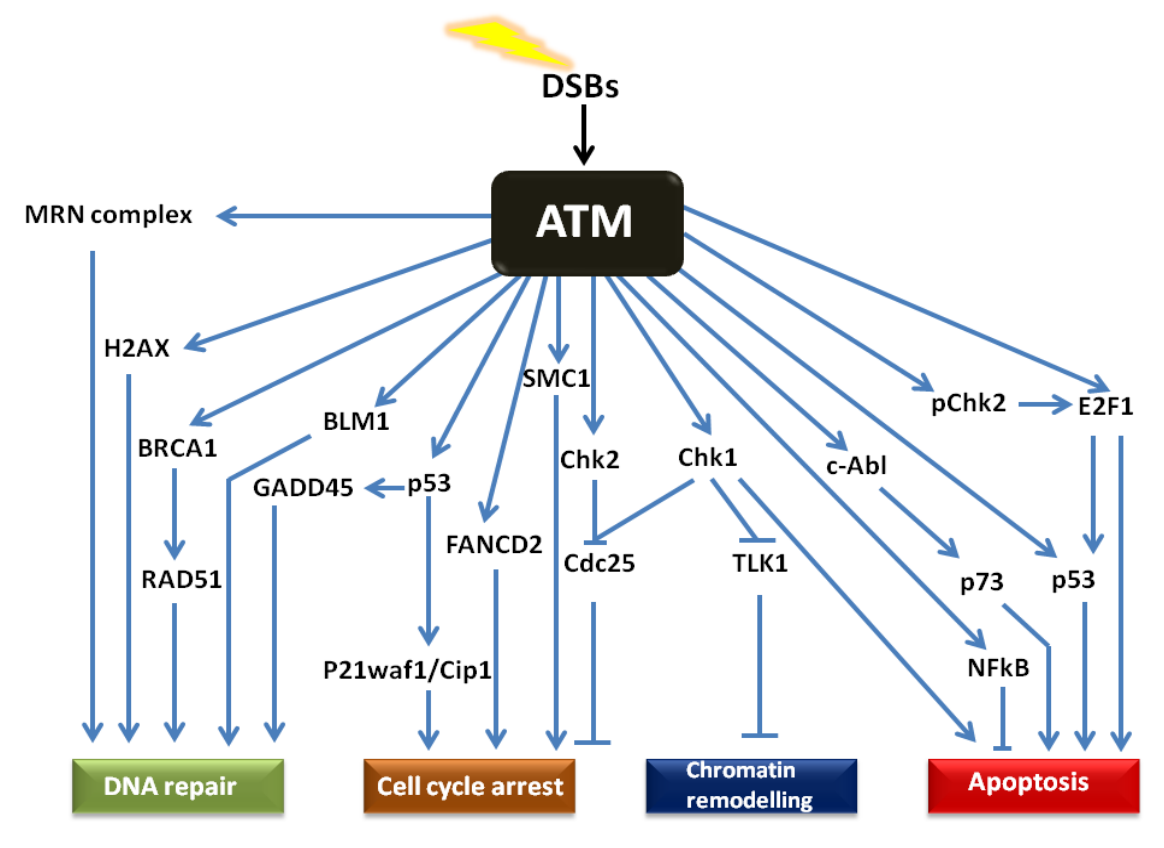
Figure 2: The ATM signalling pathway. ATM is present at the core of DNA damage pathway, activated upon DSBs and functions via multiple routes. While great deal of cross-talk exists between individual pathways, its major downstream substrates for DNA repair are MRN complex, BRCA1, RAD51 and, P53, for cell cycle arrest are SMC1, CIP/KIP family of proteins via P53 and checkpoint kinases, for chromatic remodelling are Chk1 and for apoptosis are c-Abl, P53, Chk2, E2F1, P73 and NF  B. The figure is designed on the basis of data from 50, 51, 52, 53, 54,